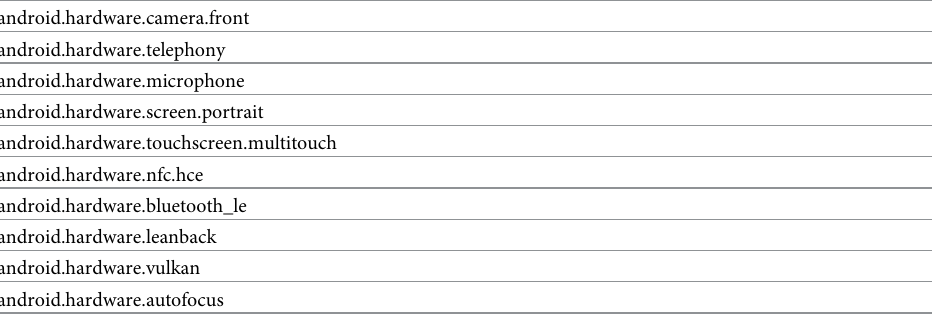
Table 7. The top ten hardware of the frequency similarity weight